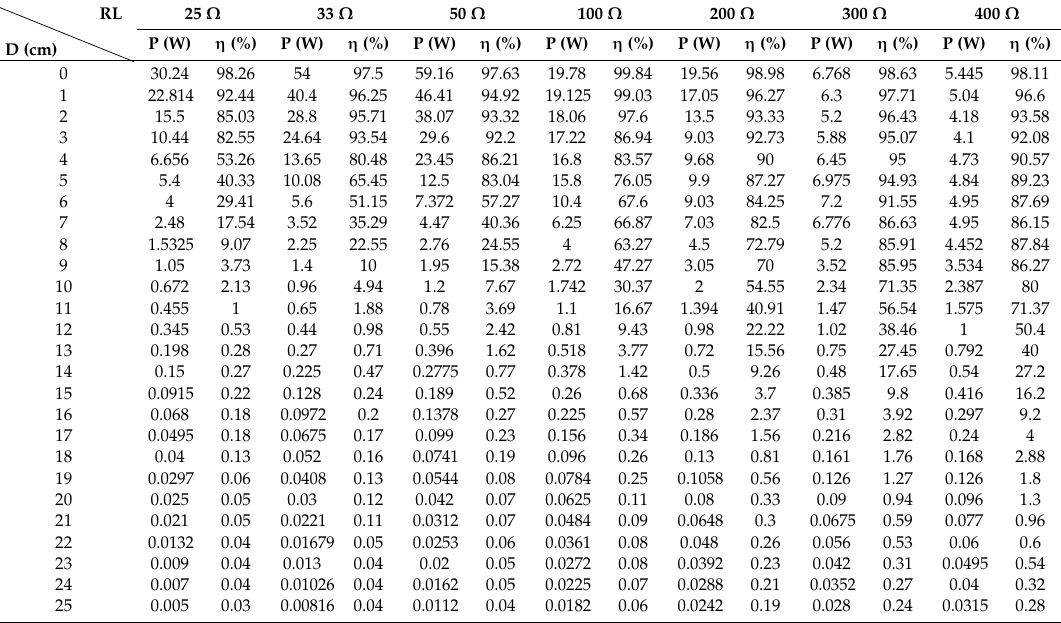
Table 5. The parameters for MRC based-loads at third topology at